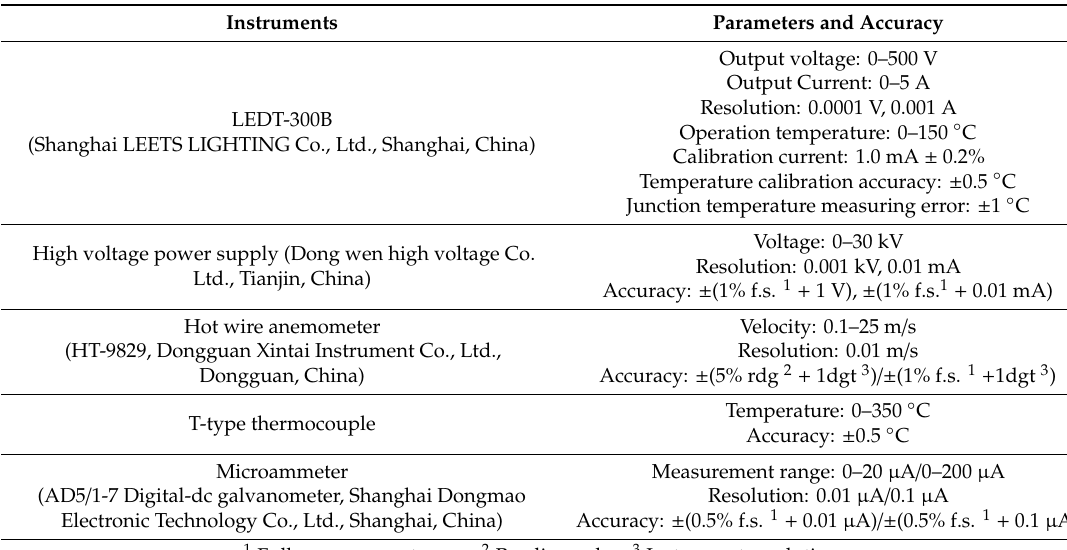
Table 1. Detailed information of Instruments.